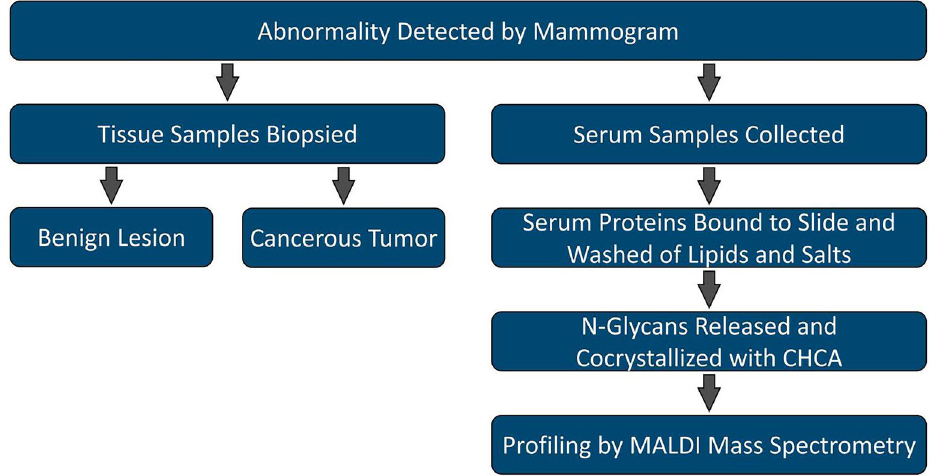
Figure 1. Sample collection, processing, and analysis overview. MALDI, matrix-assisted laser/desporption ionization; CHCA, α-cyano-4-hydroxycinnamic acid.